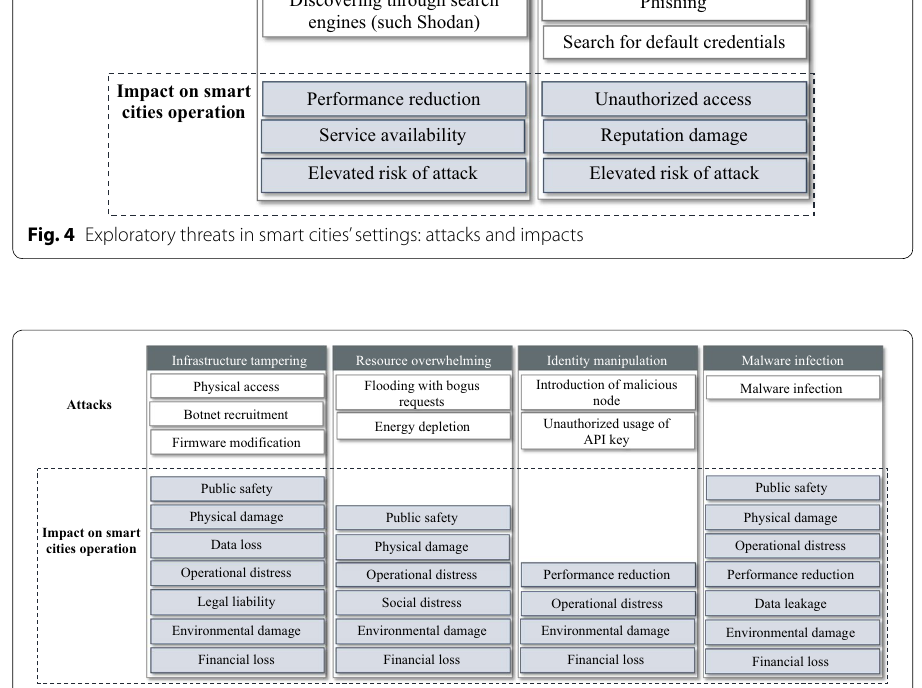
Fig. 5 Infrastructure sabotage in smart cities’ settings: attacks and